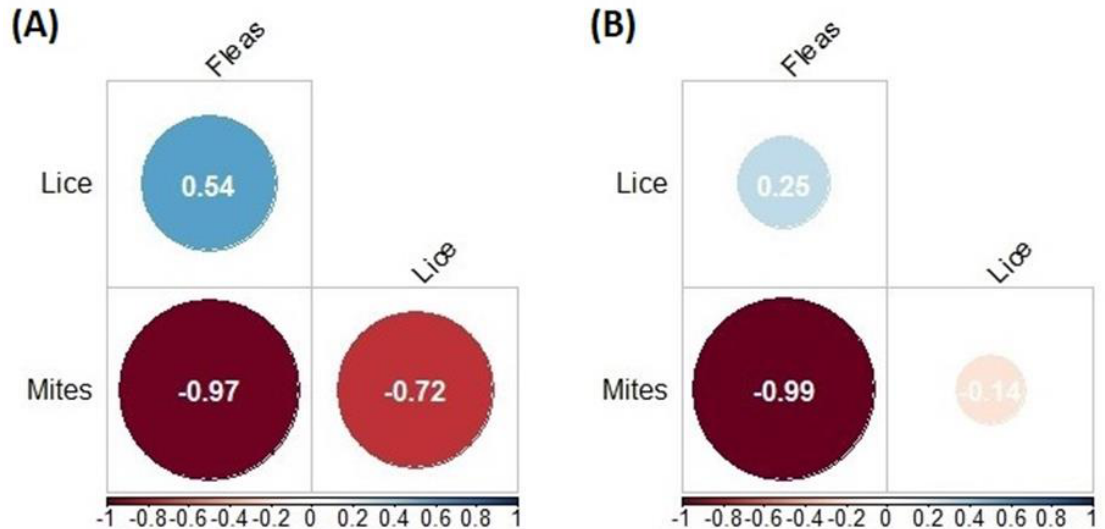
Figure 3. Correlations between abundance of ectoparasites due to explanatory ( A ) and latent ( B ) variables based on the CRM. Significant correlations (i.e., 95% confidence interval not overlapping zero) are represented by solid colours, while transparent ones represent non-significant correlations. The strength of correlations is represented by the size of the circles.